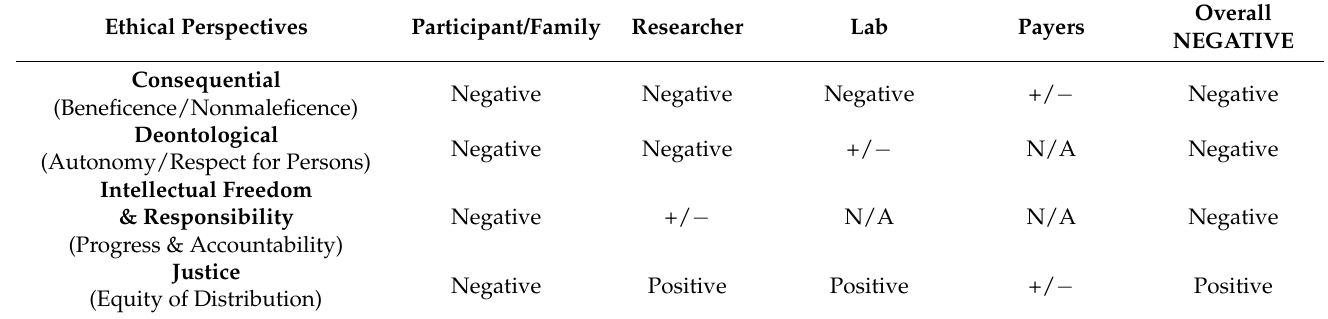
Table 4. Current